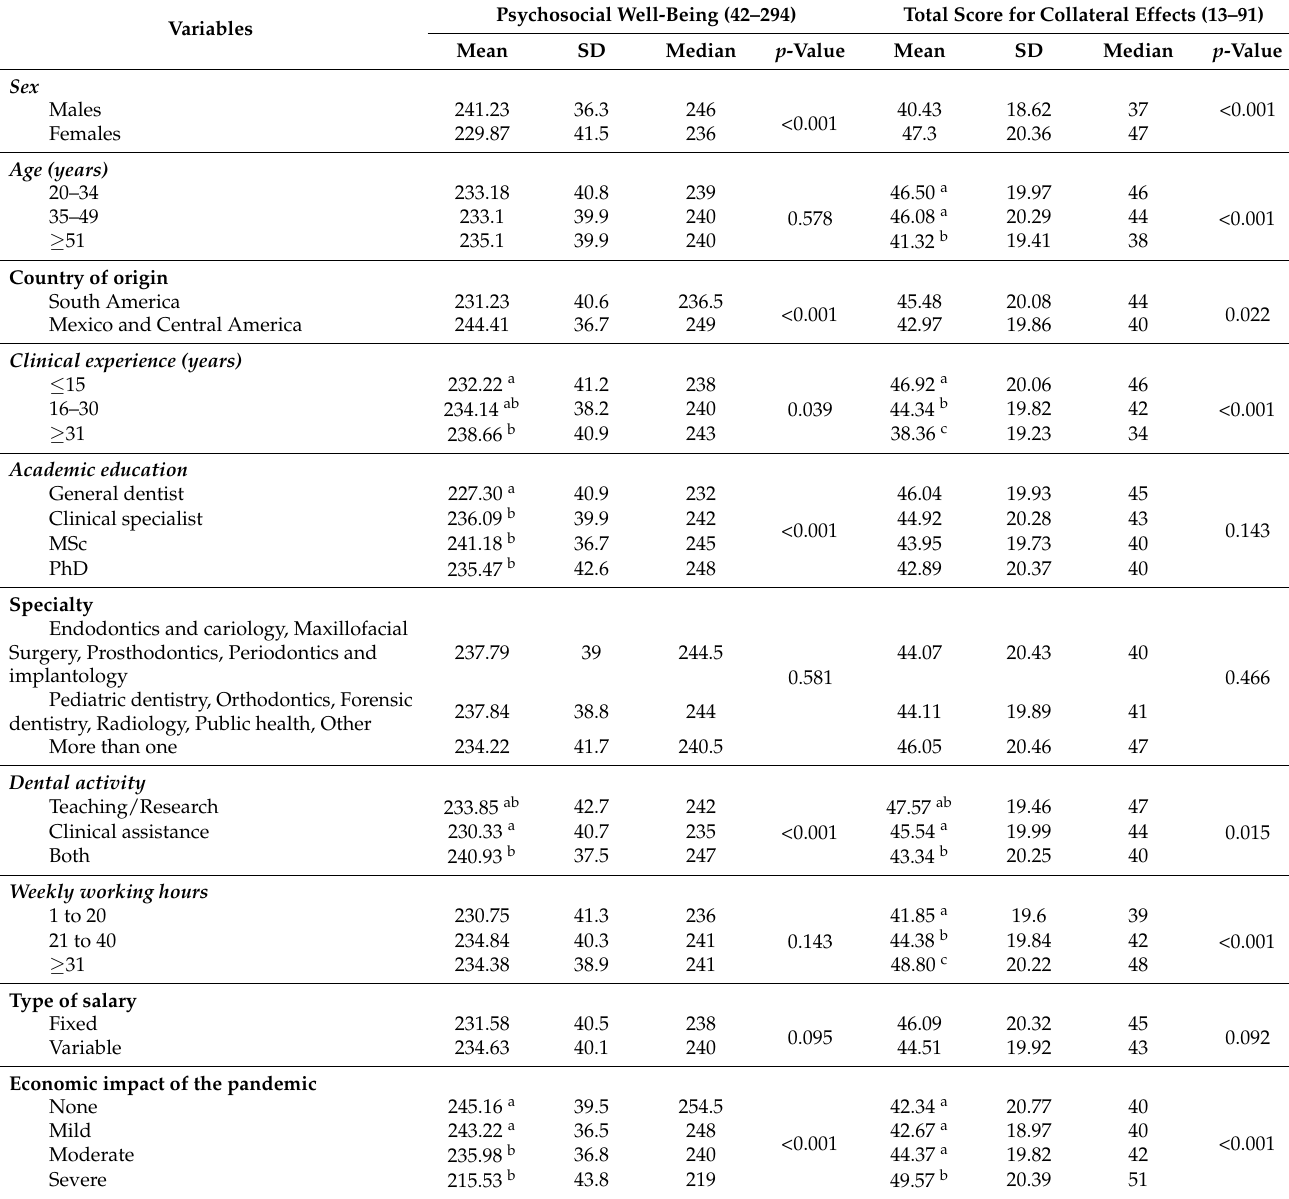
Table 2. Psychosocial well-being and total score for collateral effects according to characteristics of the